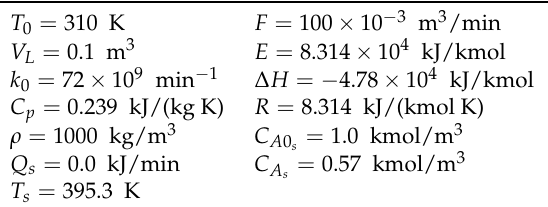
Table 1. Parameter values of the